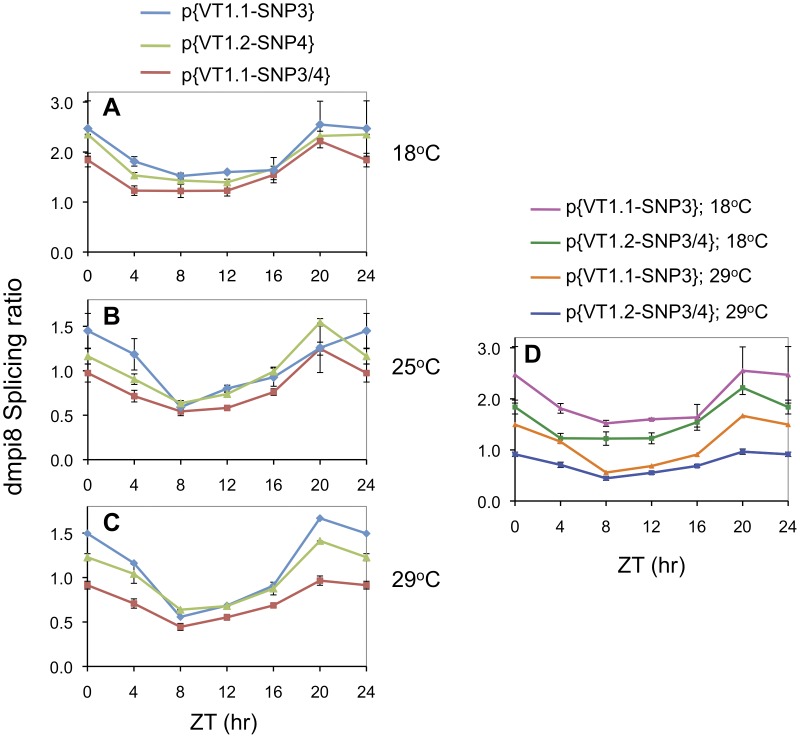
SNPs 3 and 4 from the VT1.2 haplotype reduce the daily splicing efficiency of the dmpi8 intron. A–C.The different transgenic flies, p{VT1.1-SNP3} (blue), p{VT1.1-SNP4} (green) and p{VT1.1-SNP3/4} (red) were exposed to five LD cycles at 18° (A), 25° (B) or 29°C (C). Flies were collected at the indicated times during the last LD, head extracts prepared and shown is the ratio of dmpi8 intron spliced to unspliced dper mRNA. D. Shown is an overlay of dmpi8 splicing in p{VT1.1-SNP3} and p{VT1.1-SNP3/4} flies at 18° and 29°C (see top of panel) to more easily illustrate that irrespective of the SNP3/4 variant, dmpi8 splicing remains temperature sensitive. For each panel, data from at least three independent experiments were combined to generate the graphs shown. At all temperatures tested, the splicing efficiency for the dmpi8 intron in p{VT1.1-SNP3/4} flies is significantly different from that in either p{VT1.1-SNP3} or p{VT1.1-SNP4} flies (ANOVA, p < 0.01). ANOVA analysis also showed significant temperature effects (p < 0.01) on dmpi8 splicing efficiency for all three genotypes. Note, in this figure the ratio of dmpi8 spliced transcripts to those transcripts where the dmpi8 intron is retained is shown instead of the proportion of dper transcripts with dmpi8 spliced, as in figures 2 and 4. Although both methods of plotting yield similar results, using the ratio enhances visualizing the relative differences in the daily dmpi8 splicing curves when comparing these three hybrid genotypes.